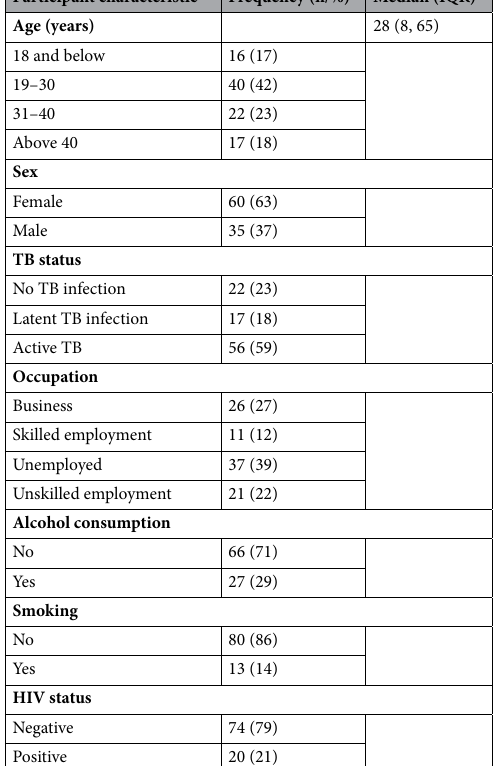
Table 1. Baseline sociodemographic characteristics of participants. n is the number of variables with their percentages and IQR is the interquartile range of the